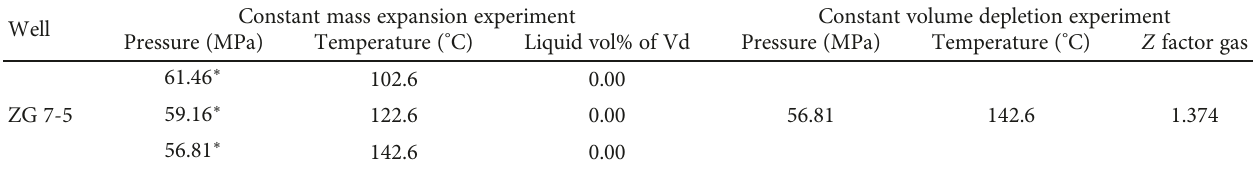
Table 2: Experimental data for constant mass expansion and constant volume depletion.